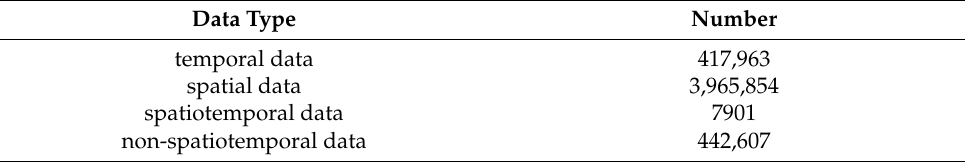
Table 3. Statistics of the synthetic